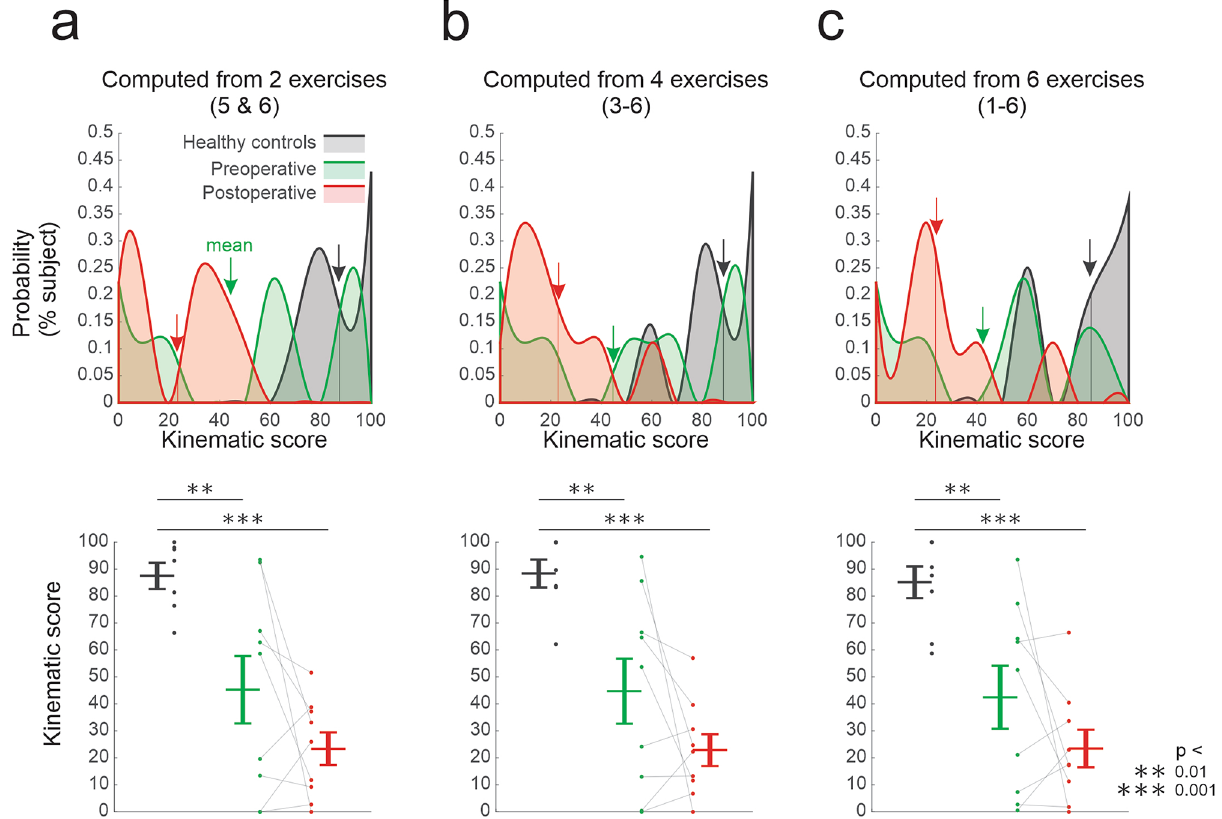
Figure 6. Comparison kinematic scores computed for ( a ) the 2 most informative gaze stabilization exercises (standing far), ( b ) 4 gaze stabilization exercises (3 to 6), and ( c ) across all 6 exercises. ( a – c ) Top: Probability distributions of the kinematic scores computed for healthy controls (black), pre-operatively (green), and post-op patients (red). Arrows indicate the average values. Bottom: Comparison of the kinematic scores of healthy controls versus unilateral vestibular patients. Vertical lines correspond to the mean ± SEM of the kinematic score for each group, while the kinematic scores for individual subjects are illustrated as points. Asterisks denote significant difference between healthy controls and patients (*p < 0.05, **p < 0.01, ***p <